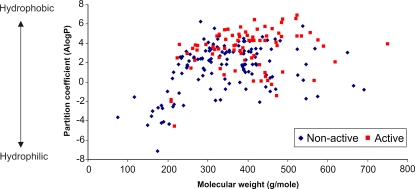
Hydrophobicity and Molecular Weight Discrimination for Non-Active and Active Compounds.All compounds tested were plotted as a function of logP and molecular weight.